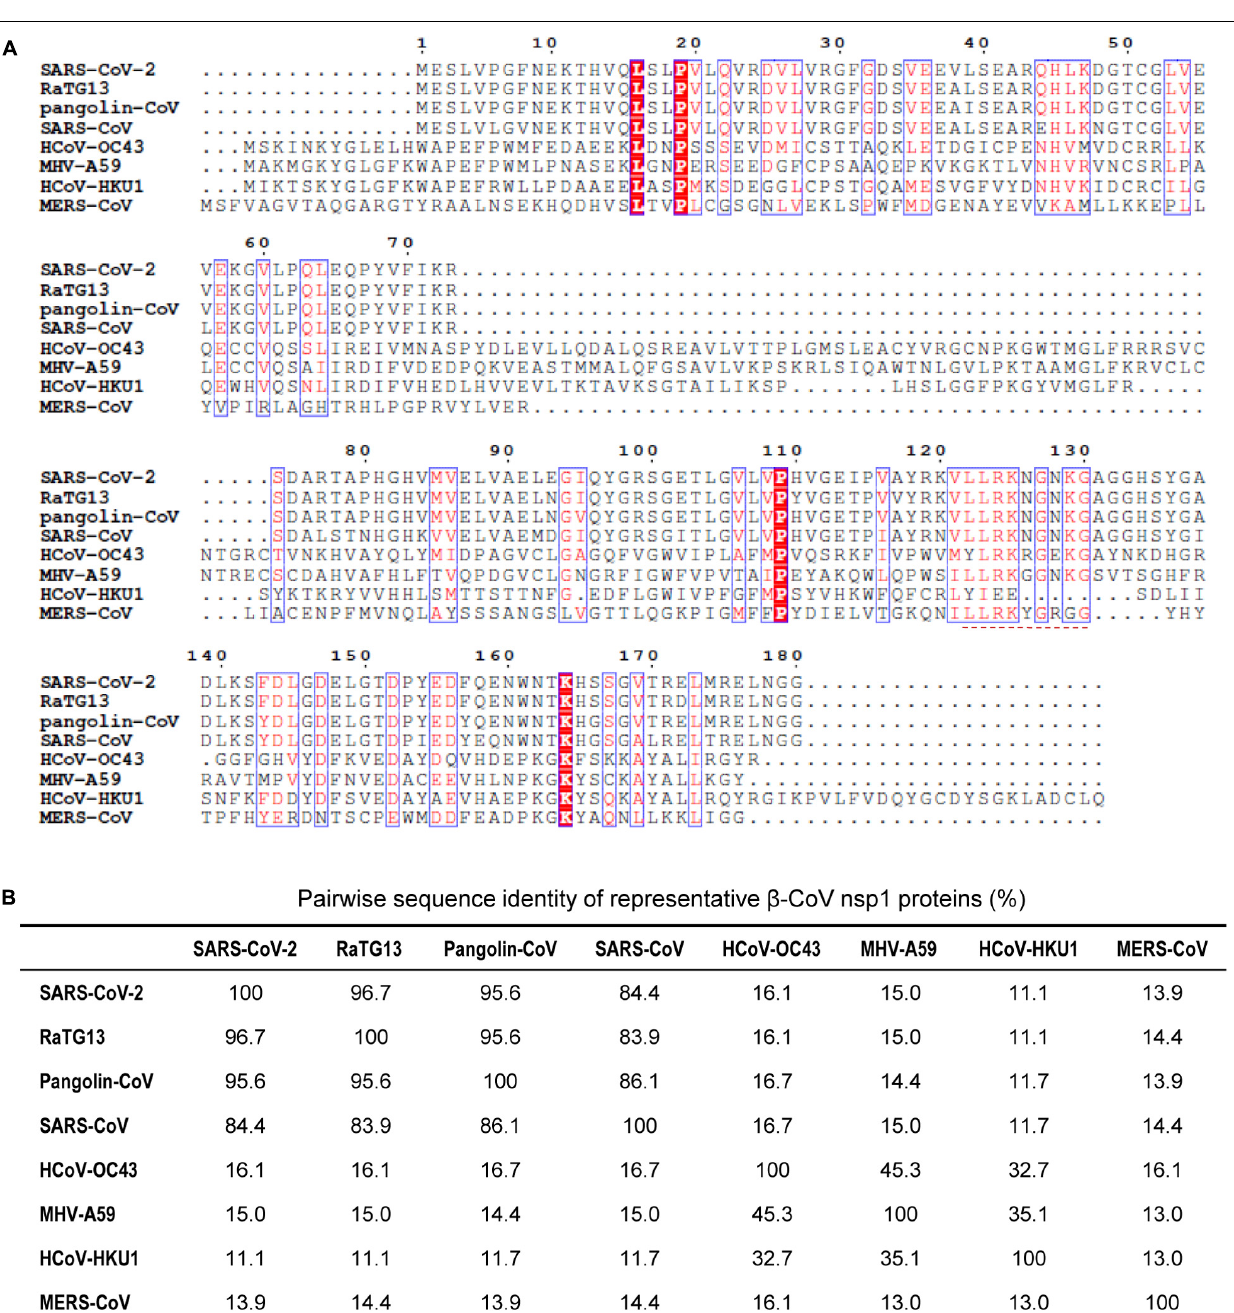
FIGURE 3 | Comparison of representative β -CoV nsp1 sequences. (A) Amino acid sequence alignment of nsp1 encoded by several representative β -CoVs were performed by Clustal X Version 2.1 and viewed by ESPript. The numbers above the aligned sequences indicate the amino acid sites of SARS-CoV-2 nsp1. The amino acids conserved in all the analyzed nsp1 sequences are shown in white with red background. The residues conserved in most of the analyzed sequences are shown in red and boxed in blue. A region highly conserved among β -CoVs (corresponding to amino acids 122-130 of SARS-CoV-2 nsp1) is indicated with a red dashed line. (B) Summary of the sequence identity percentage of β -CoV nsp1 in pairwise comparison. Virus strains of SARS-CoV-2 and SARS-CoV used here are Wuhan-Hu-1 and SZ3,